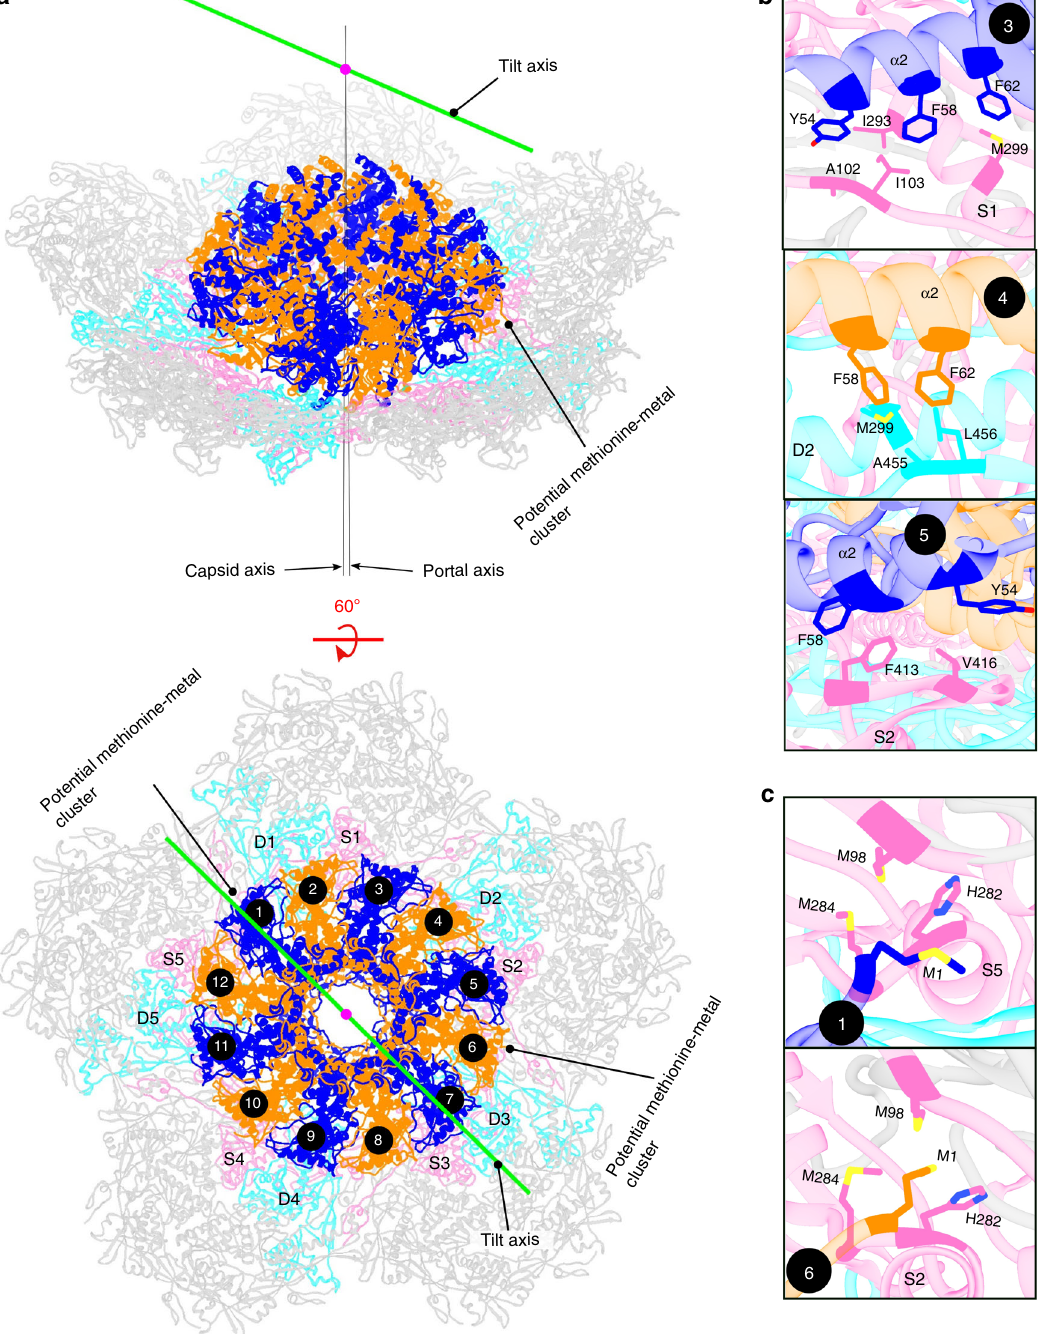
Fig. 4 Tilt between the portal and the capsid and potential metal-binding clusters. The portal assembly and the surrounding gp23* capsomers are colored and labeled as in Fig. 1a. a Tilt between the portal and the capsid. The tilt axis, portal axis, and capsid axis are shown. b Hydrophobic interaction between gp20 α 2 and gp23* capsomers. c The potential methionine-metal clusters formed between the N-whisker methionine (M1) of subunits 1 and 6 of gp20 and subunits S5 and S2 of gp23*. Residues involved in forming the metal binding sites are